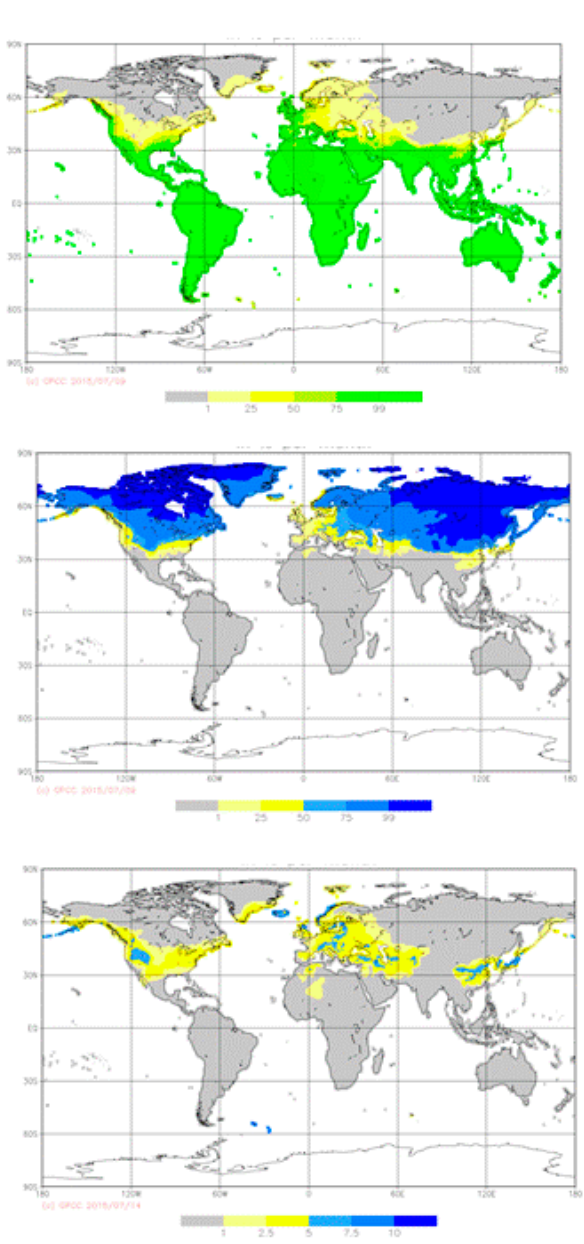
Figure 10. Example of the mean percentage of precipitation phases for January over the period 1982–2015 ( top ) liquid, ( middle ) solid and ( bottom ) mixed phase. Averaging the GPCC’s land surface weather-dependent correction month-by-month for the global land surface (excluding Antarctica) and over the entire period 1982–2015 provides the mean correction factors in Table 1 for each calendar month and the entire year.